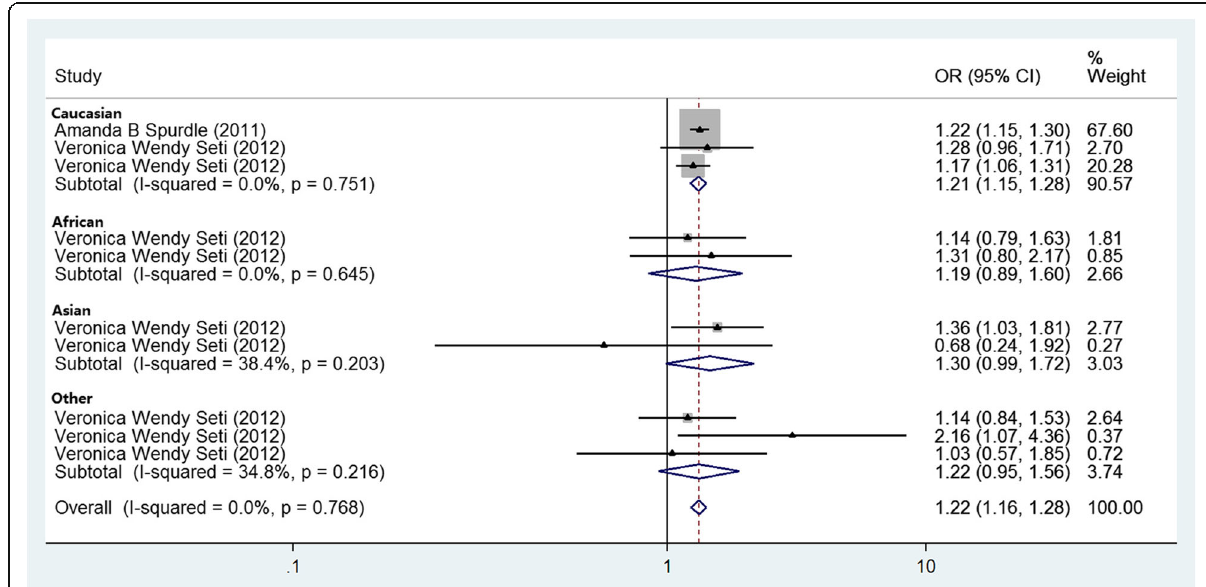
Fig. 3 Fixed-effects meta-analysis of allele (A versus G) of the HNF1B gene rs4430796 G>A and endometrial cancer. The OR of each study is represented by a square, and the size of the square represents the weight of each study with respect to the overall estimate. 95% CIs are represented by the horizontal lines, and the diamond represents the overall estimate and its 95%